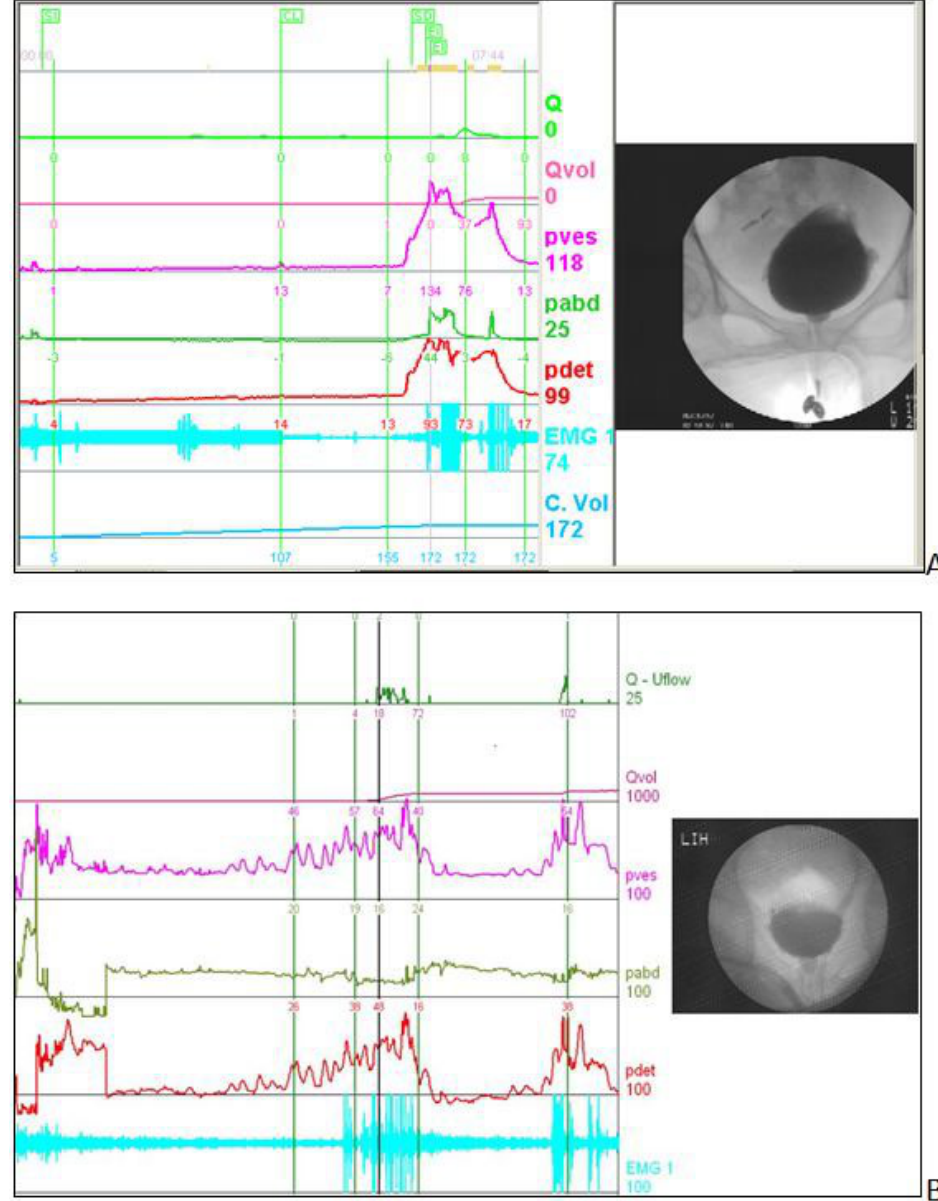
Figure 1. Video urodynamic tracings of children with dysfunctional voiding. ( A ) shows the tracing of a patient with high voiding pressure, low flow rate, increased urethral sphincter electromyographic activity, and tight urethra sphincter during voiding. ( B ) shows the tracing of a patient with detrusor overactivity during bladder filling, with high detrusor pressure, tight urethral sphincter, and right vesicoureteral reflux during voiding. Q, flow rate; Qvol, voided volume; Pve, intravesical pressure; Pabd, intra-abdominal pressure; Pdet, detrusor pressure; EMG, electromyogram of external sphincter. All patients were treated with antimuscarinics, α -blockers, or baclofen for DO and ure- thral sphincter hyperactivity after confirming DV. Additionally, children older than 5 years, who were able to follow the instructions and perform PFMT, underwent biofeedback-based PFMT. Unilateral or bilateral ureteral reimplantation had been performed in patients